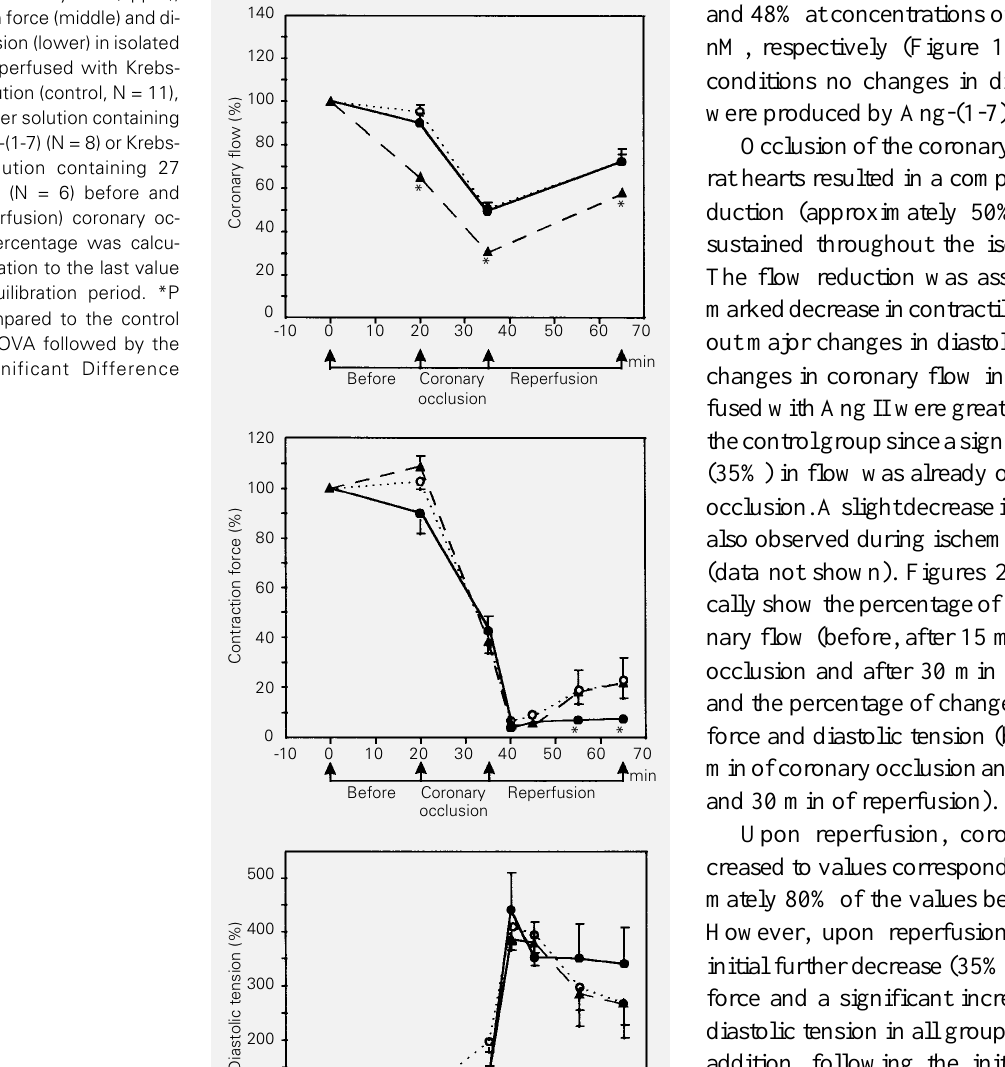
Figure 2 - Coronary flow (upper), contraction force (middle) and di- astolic tension (lower) in isolated rat hearts perfused with Krebs- Ringer solution (control, N = 11), Krebs-Ringer solution containing 27 nM Ang-(1-7) (N = 8) or Krebs- Ringer solution containing 27 nM Ang II (N = 6) before and after (reperfusion) coronary oc- clusion. Percentage was calcu- lated in relation to the last value of the equilibration period. *P <0.05 compared to the control group (ANOVA followed by the Least Significant Difference